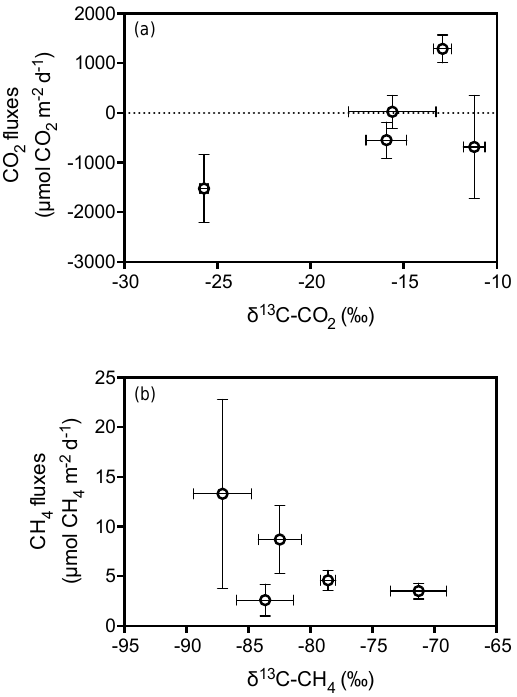
Figure 5. Relation between (a) the carbon isotopic signature of the produced CO 2 ( δ 13 C–CO 2 ) and CO 2 fluxes and (b) carbon isotopic signature of the produced CH 4 ( δ 13 C–CH 4 ) and the CH 4 fluxes in Red Sea mangroves. Error bars indicate standard error of the